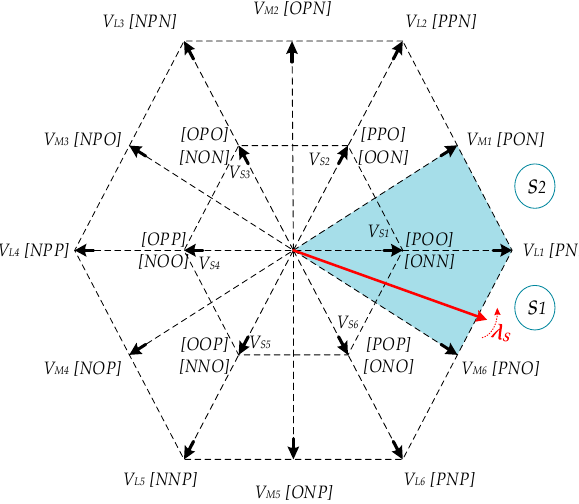
Figure 4. Space vector diagram of the three-level NPC inverter.